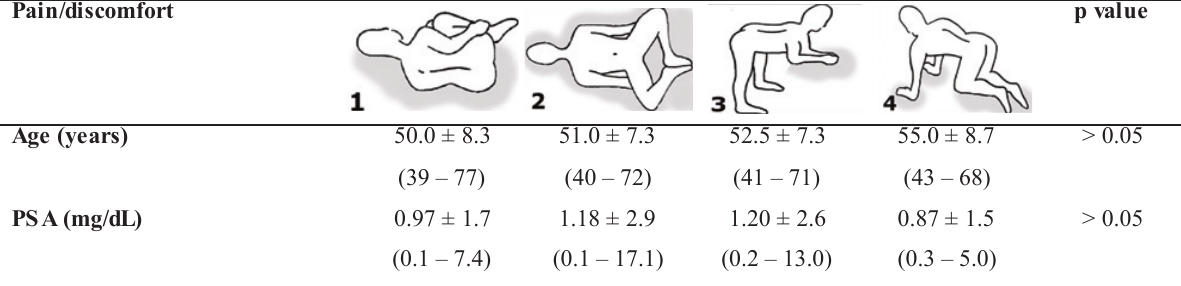
Table 2 – Age and PSA level of the patients. Table 2 - Age and PSA level of the patients.